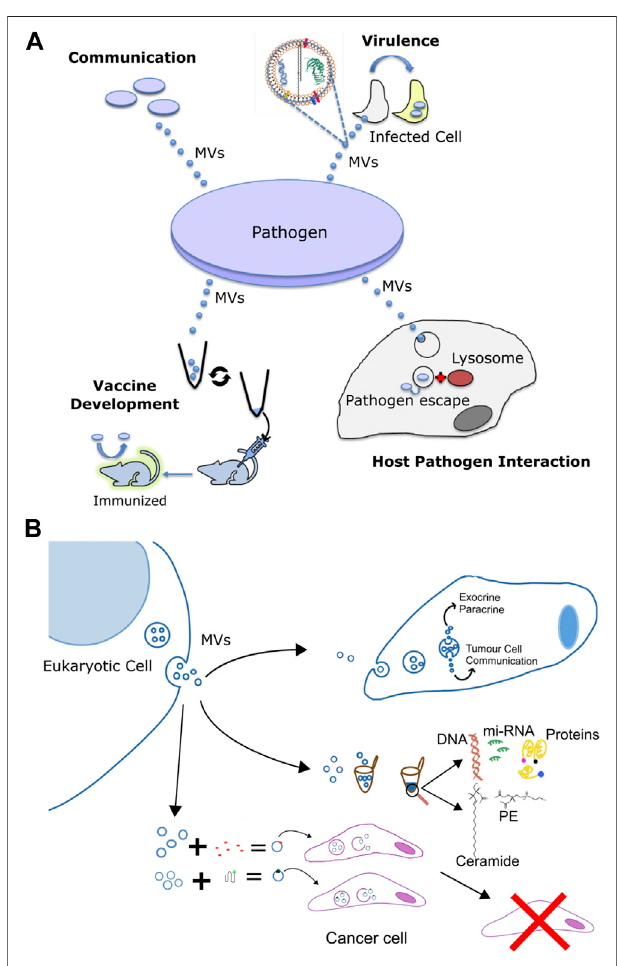
FIGURE 3 | Multifaceted functions of membrane vesicles. (A) Pathogen derived membrane vesicles (MV) aid in communication, in the delivery of virulence factors to host cells during infection, as well as in altering interaction with the host and the use of the bacterial OMVs for the development of immunization against the pathogen. (B) Speci fi c applications of eukaryotic membrane vesicles for 1) intracellular signalling and transport of chemicals, 2) to serve as minimally invasive diagnostic markers against various diseases by using the eukaryotic pathogen derived MV-enclosed molecular cargos such asDNA,proteins,lipids,andmi-RNAand3)inrecombinantcancertherapyvia the combination of exosomes and nanotherapy for targeted cancer therapy. Exosomes derived from target cells are tagged with bioactive molecules (red) or functionalized protein (green) and injected into cancer cells or animal models for anti tumor therapy or help in immunization and vaccination against a particular cancer